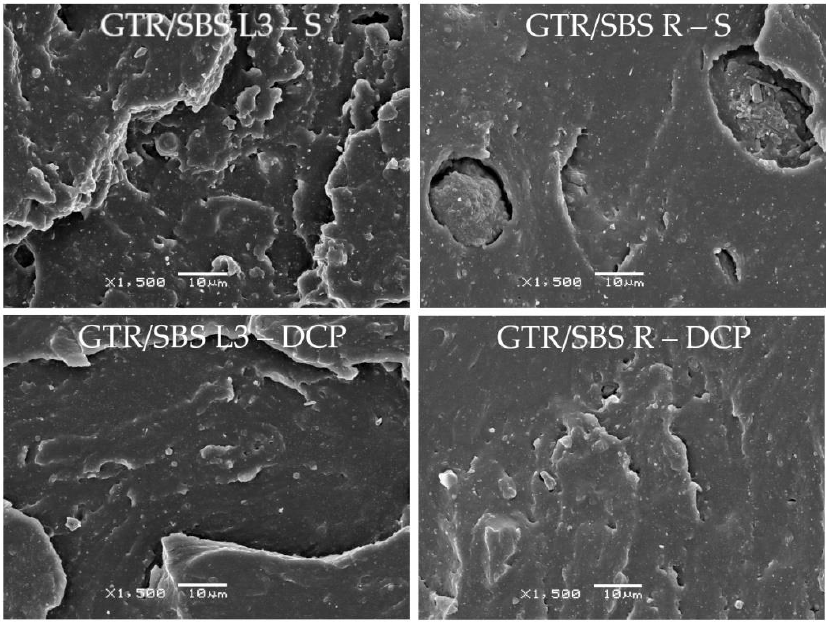
Figure 6. SEM images of GTR/SBS L1 (low-viscosity SBS) and GTR/SBS R (high-viscosity SBS) (magnification ×1500). (magnification × 1500).